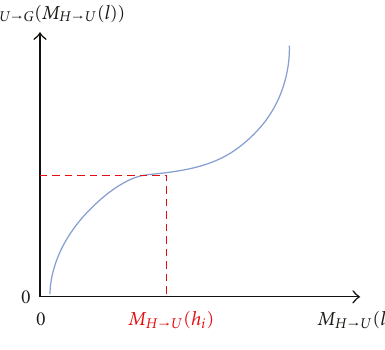
Figure 3: The distribution of M H → G ( l